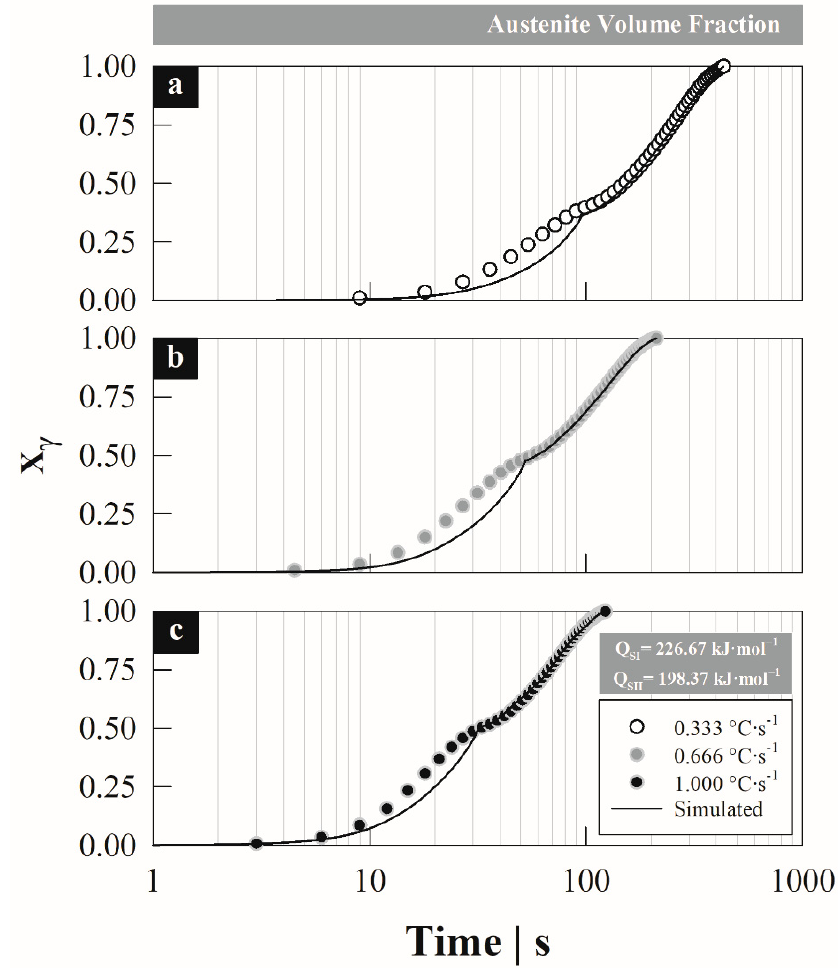
Figure 9. Comparison between the total austenite formation degree estimated with the non-isothermal model and experimental at different heating rates: ( a ) 0.33, ( b ) 0.66 y ( c ) 1.00 °C s − 1 .